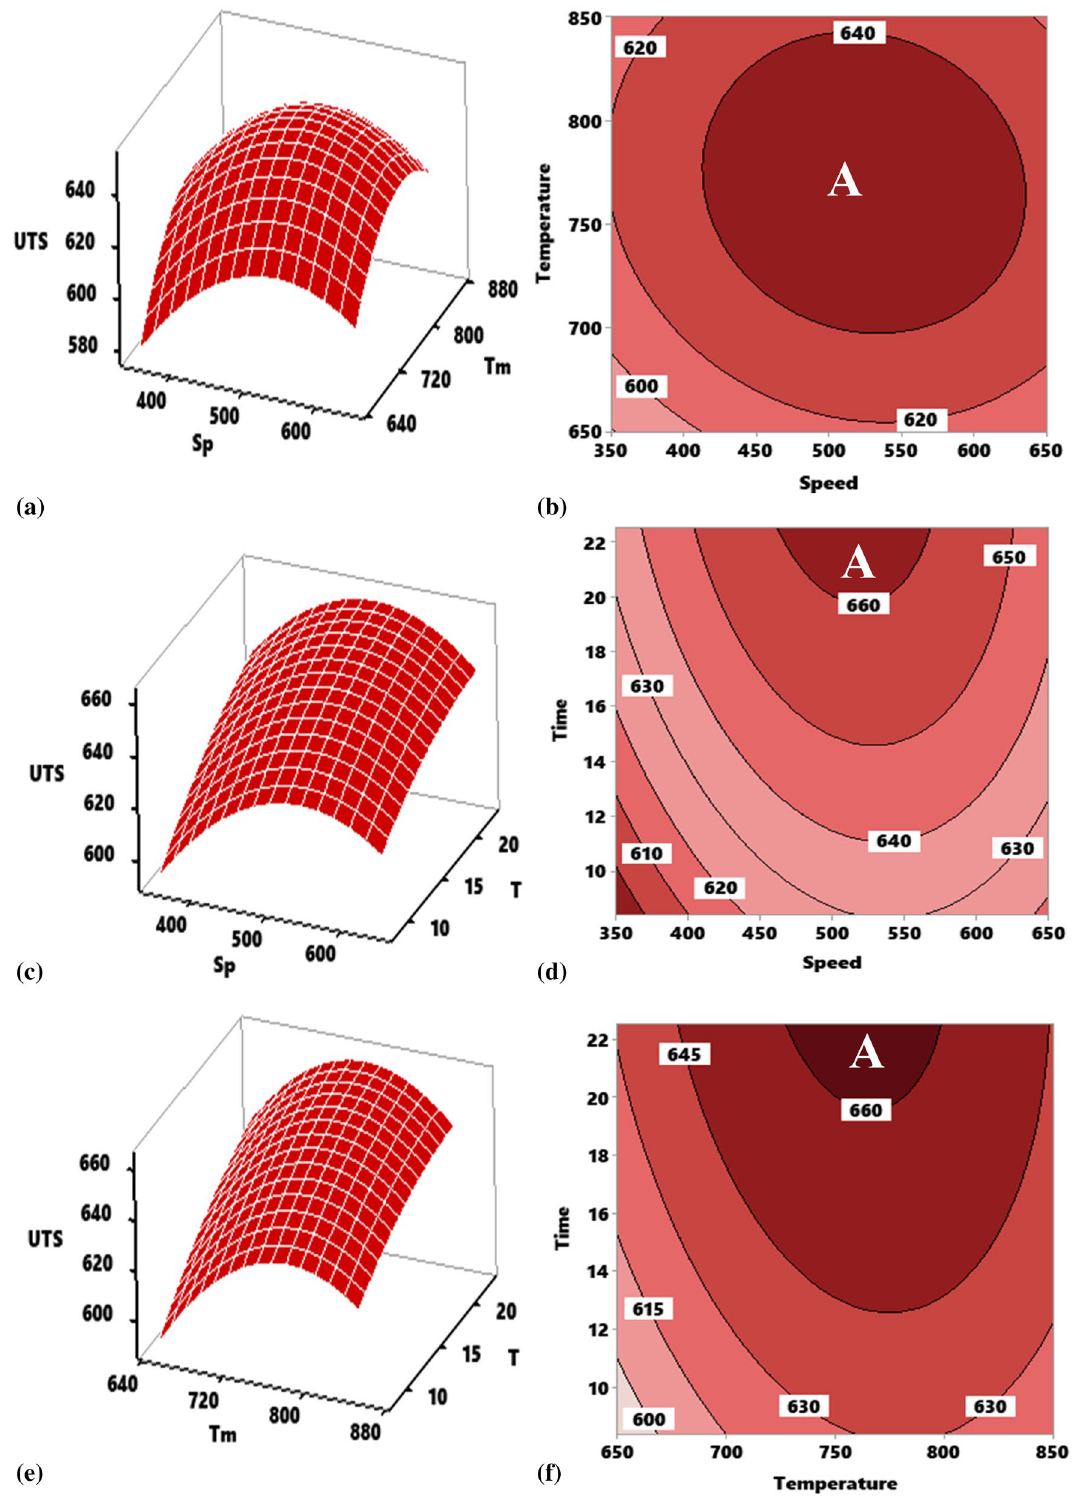
Figure 3. Influence of stirring parameter on ultimate tensile strength of developed composite as represented by response surface plot and contour plot for interactions. ( a , b ) Speed and temperature, ( c , d ) speed and time, ( e , f ) temperature and